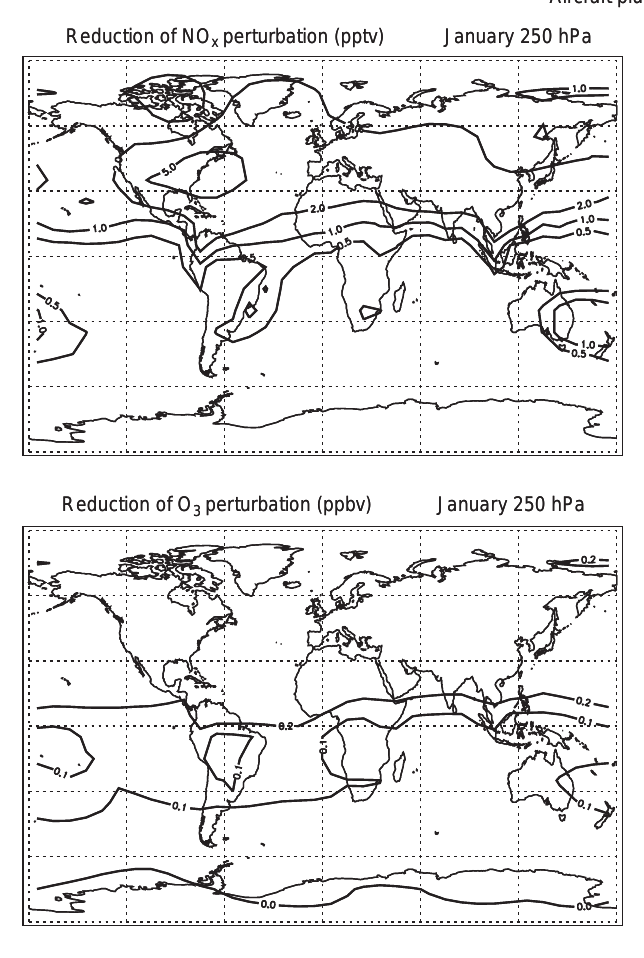
(pptv) and ozone indicate that the use of modified aircraft emissions lead to a reduction x of the NO or x